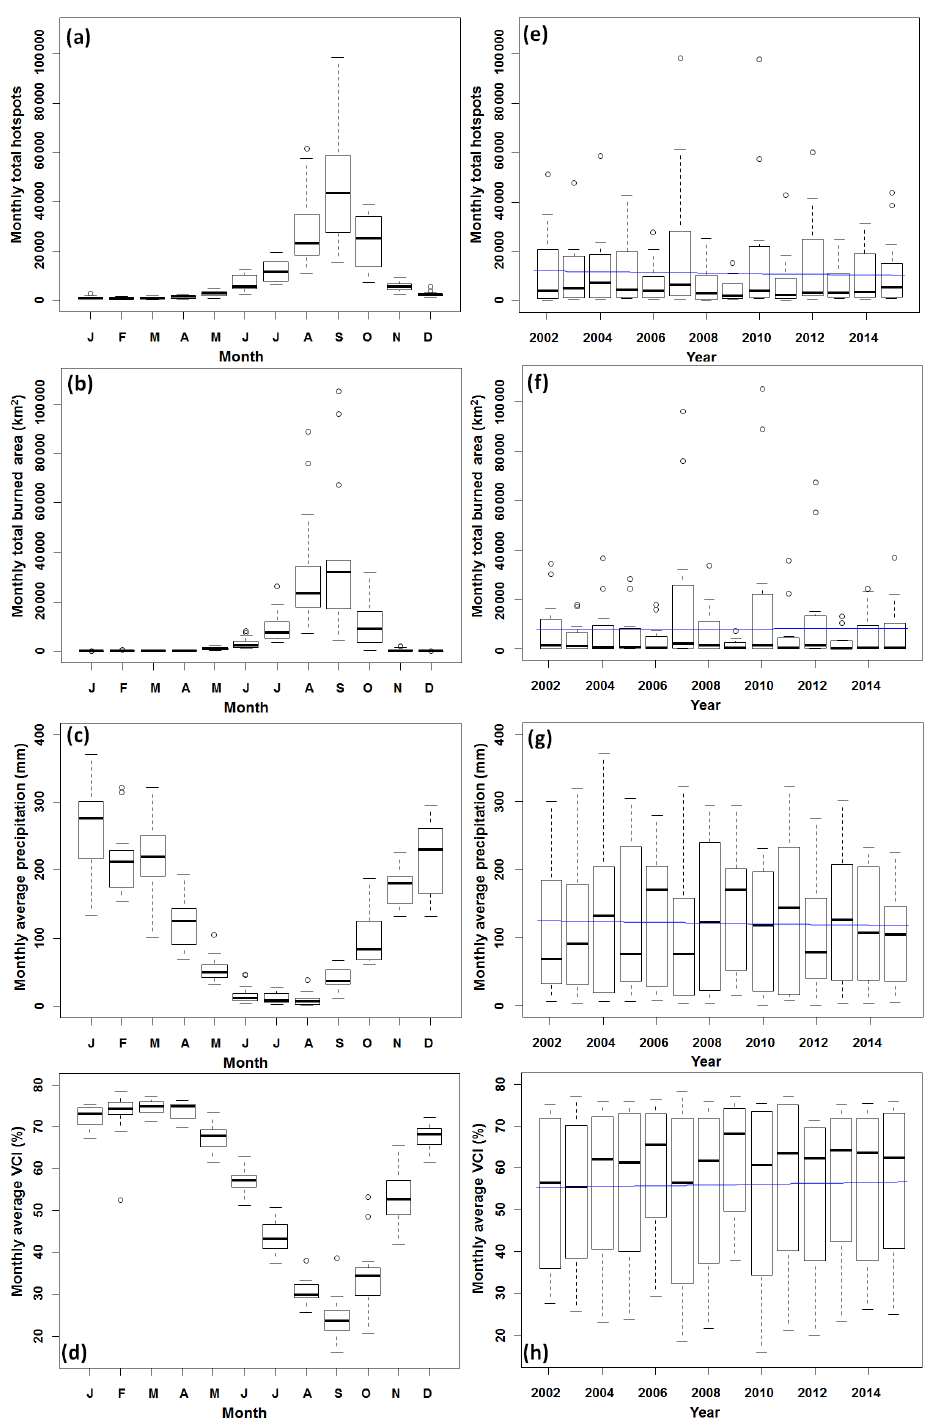
Figure 2. Interannual boxplots for (a) monthly total hotspots, (b) monthly total burned area, (c) monthly average precipitation and (d) monthly average VCI; intra-annual boxplots and trends (blue lines) for (e) monthly total hotspots, (f) monthly total burned area, (g) monthly average precipitation and (h) monthly average VCI in the Cerrado biome during the 2002–2015 period. On each boxplot, the central mark represents the median, the edges of the boxplot are the 25th and 75th percentiles and the upper (lower) whisker delimits the most extreme value contained in the limit defined by the sum (difference) between the 75th (25th) percentile and the difference between the 75th and 25th (25th and 75th) percentiles multiplied by 1.5. Outliers (black circles) represent values outside the limits defined by the